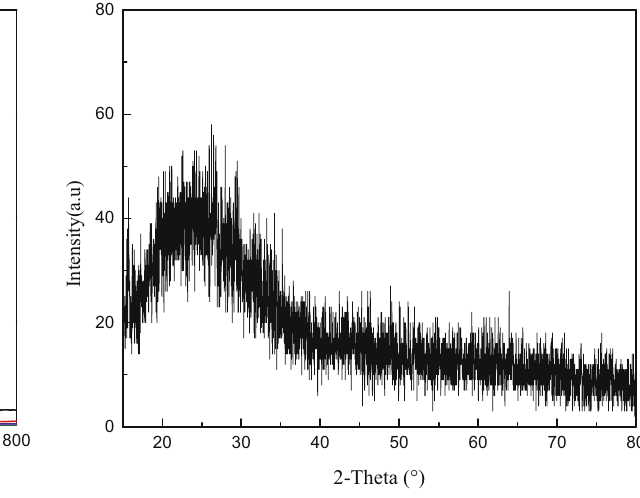
Figure 4: E ff ects of pH value on the formation of nano - selenium. Figure 5: XRD pattern of nano - selenium synthesized from lemon